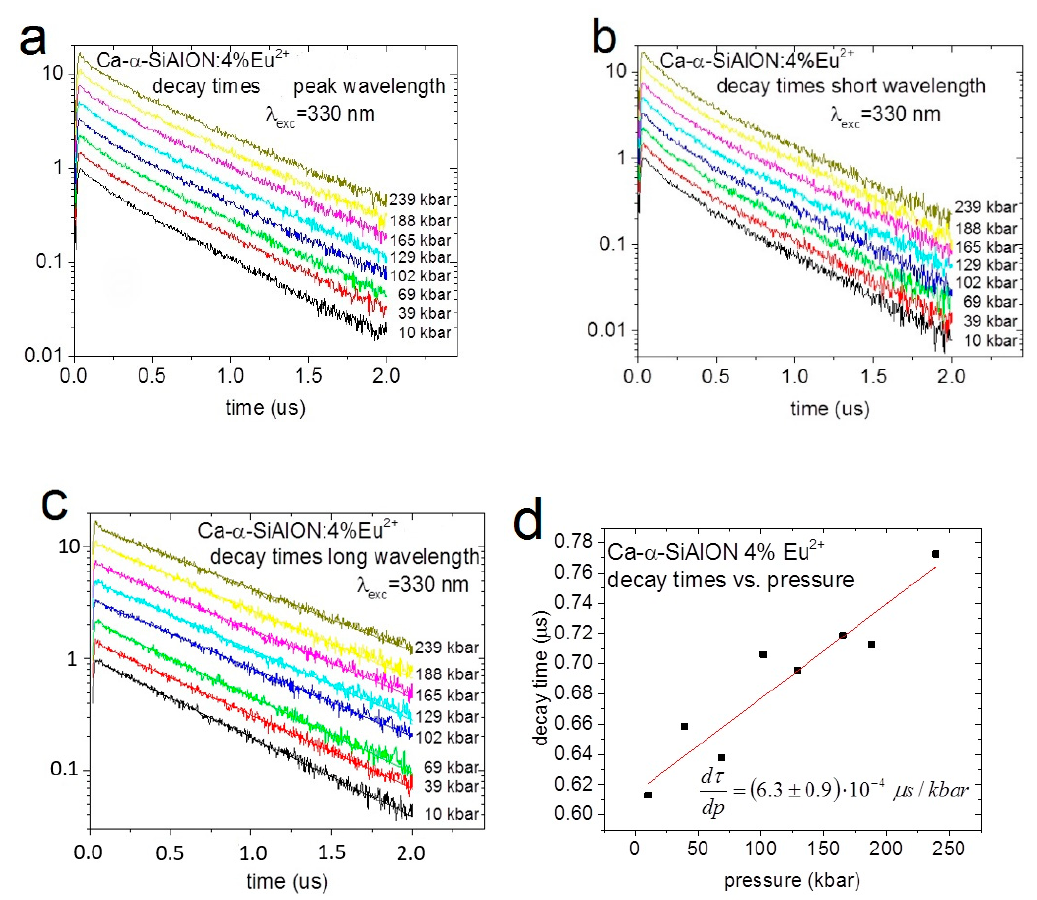
Figure 12. ( a ) Decay profiles of Ca 0.8 Si 9.6 Al 2.4 O 0.8 N 15.2 :4% Eu 2+ vs. pressure taken at peak wavelength. ( b ) Decay profiles of Ca 0.8 Si 9.6 Al 2.4 O 0.8 N 15.2 :4% Eu 2+ vs. pressure taken at short wavelengths. ( c ) Decay profiles of Ca 0.8 Si 9.6 Al 2.4 O 0.8 N 15.2 :4% Eu 2+ vs. pressure taken at long wavelengths (near the right HWHM point). ( d ) Decay times of long wavelength luminescence vs. pressure.